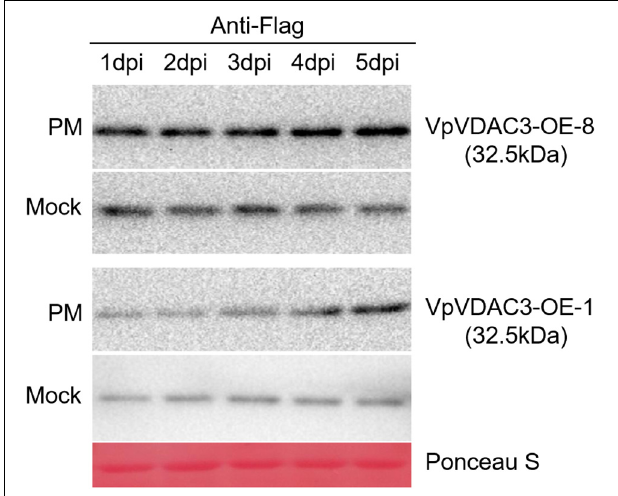
FIGURE 9 | VpVDAC3 protein accumulation during Pst DC3000 infection. Western blot analysis of two stable p35S:VpVDAC3 transgenic Arabidopsis lines ( VpVDAC -OE-3 and VpVDAC -OE-8) after Pst DC3000 inoculation. Protein samples were extracted after 1, 2, 3, 4, and 5 dpi. Data are representative of three independent